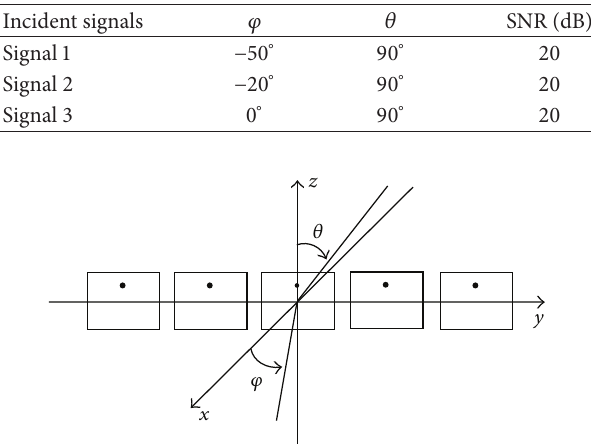
Figure 1: Structure of the linearly polarized microstrip array and the coordinate